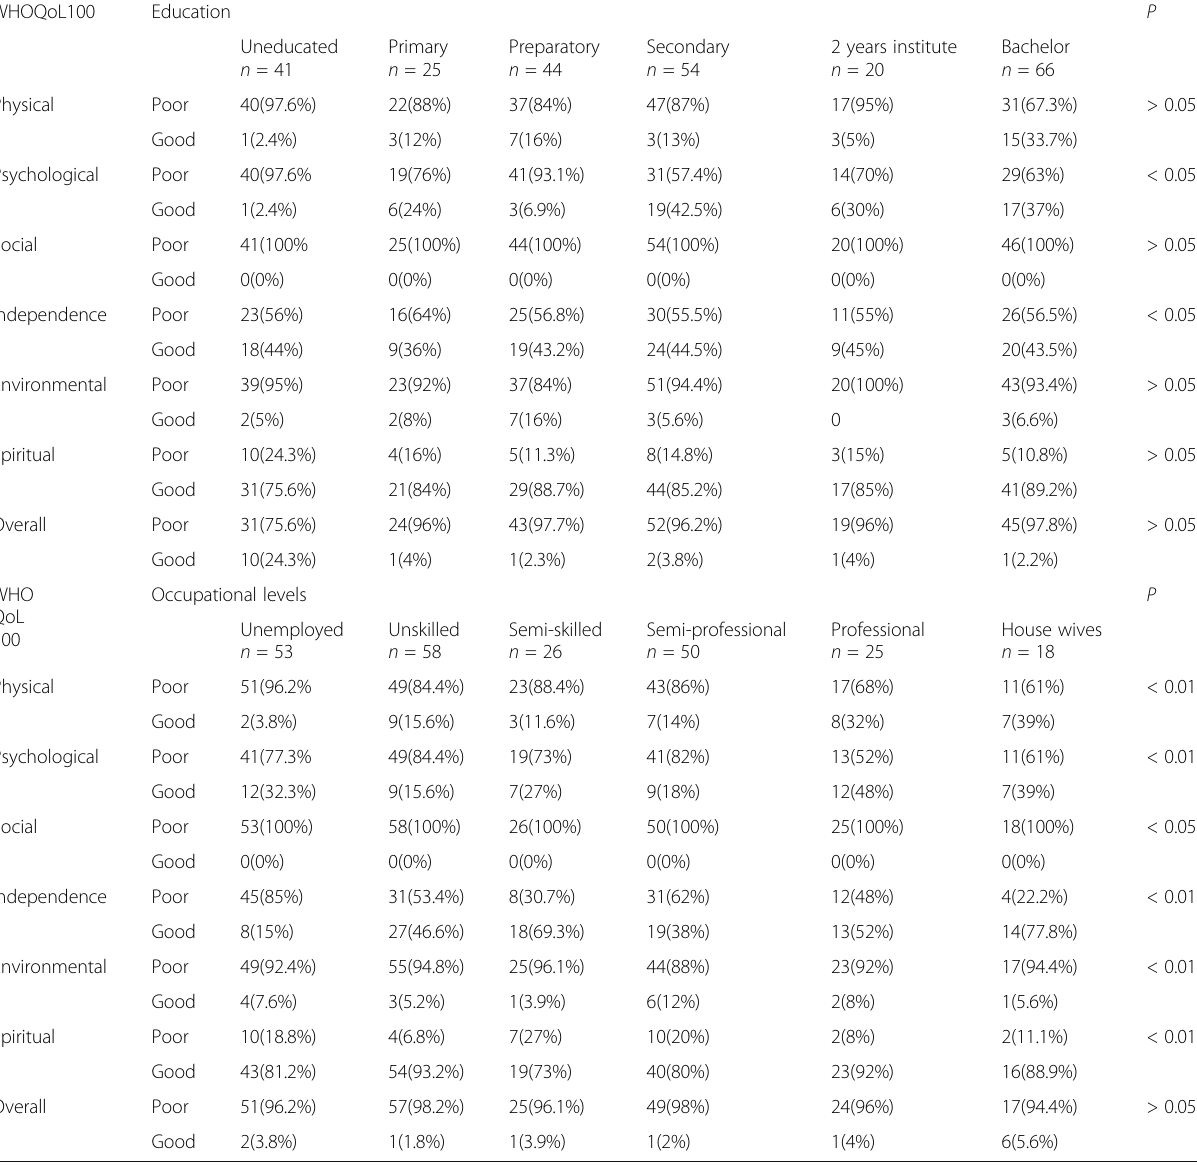
Table 2 Quality of life among PRTRs in relation to educational level and occupation